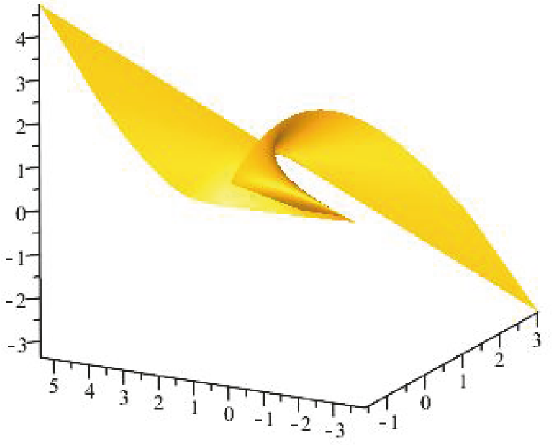
Figure13:Projectionoftheintersectionof IH 𝛾 ± (𝑠,𝜇, 𝜔) and 𝜔 = 0 on 𝑥 1 𝑥 3 𝑥 4 -space.